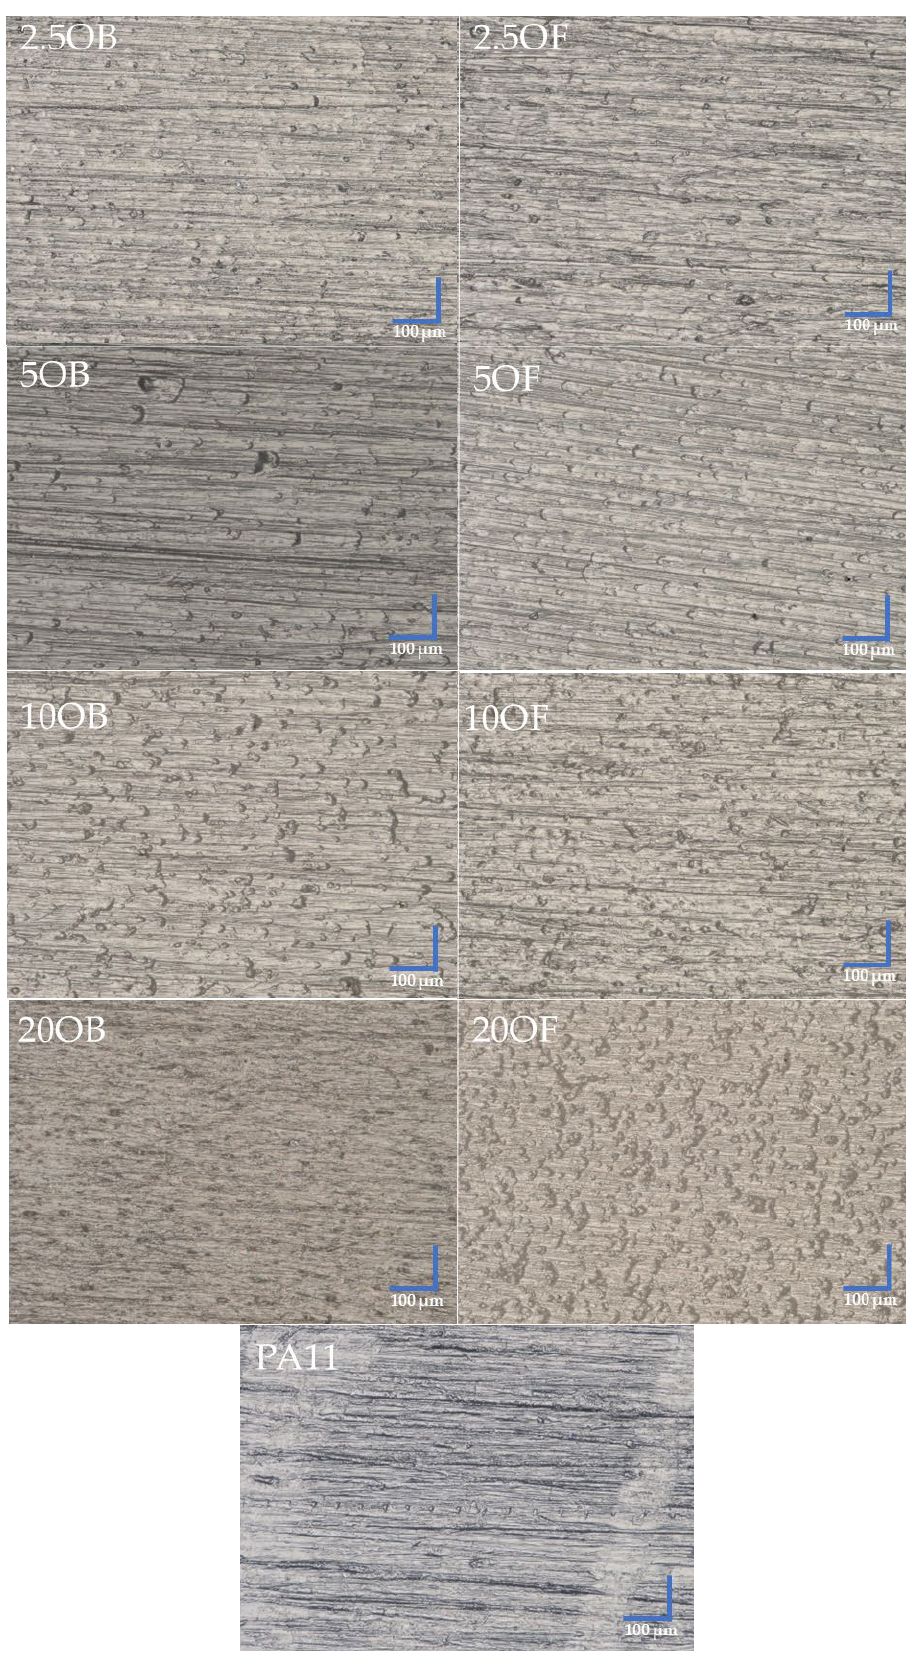
Figure 13. Surface of the biocomposites.